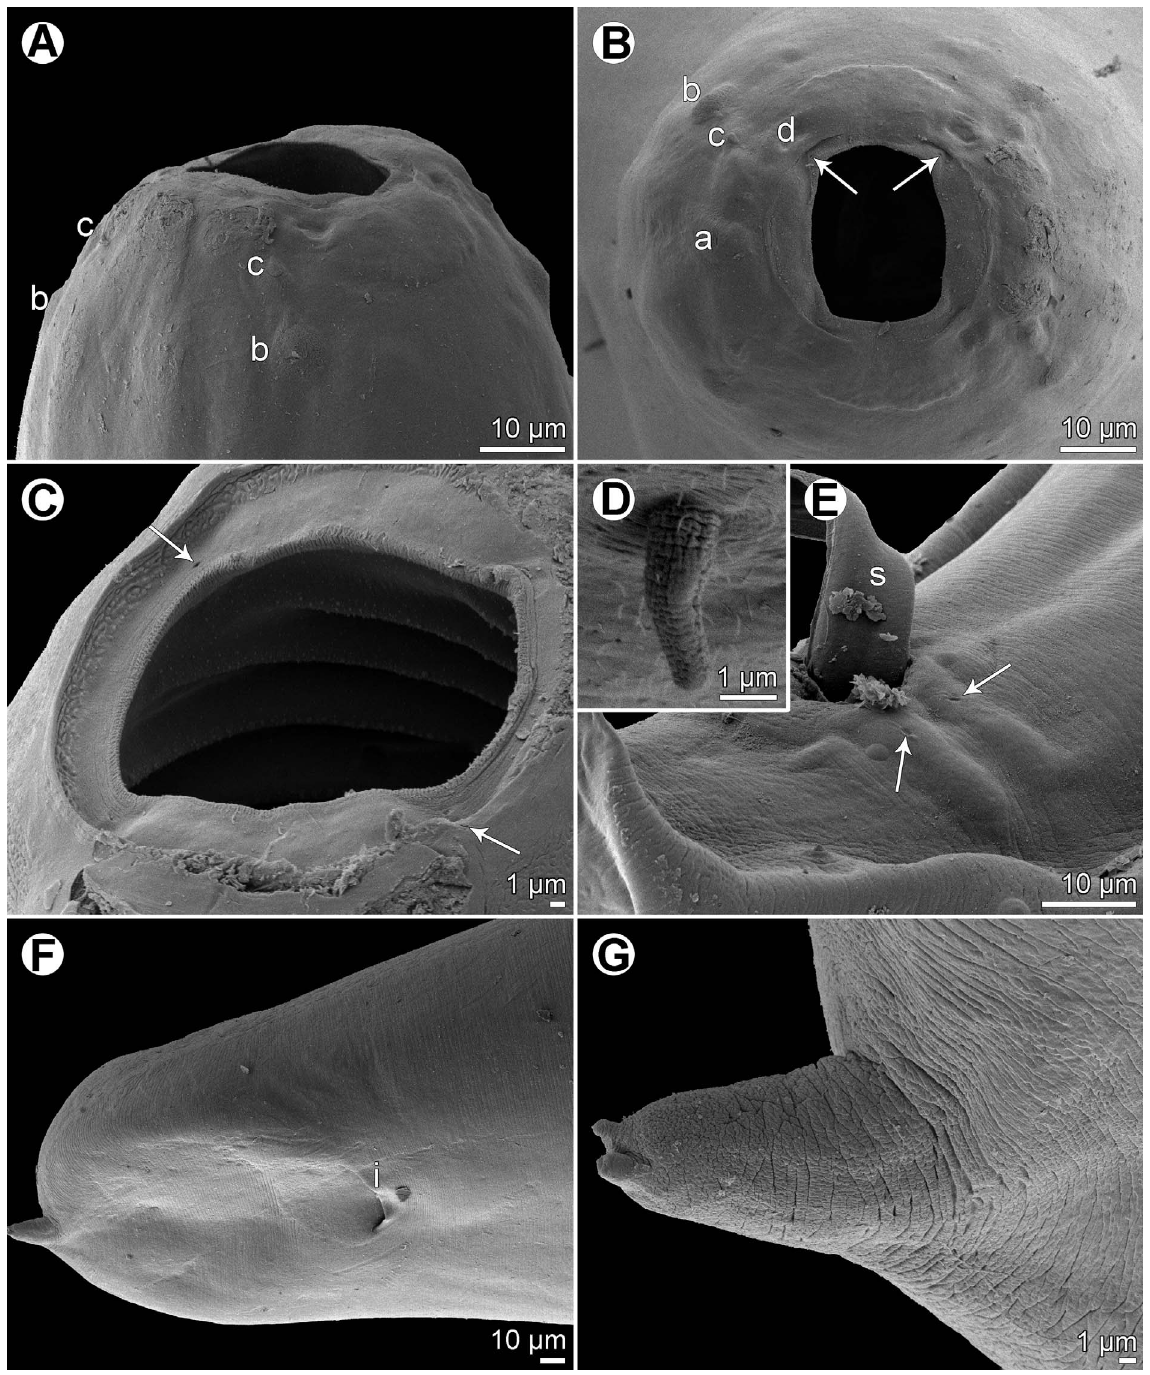
Figure 10. Procamallanus ( Spirocamallanus ) thalassomatis n. sp., scanning electron micrographs. (A, B) Cephalic end, sublateral and apical views, respectively (arrows indicate circumoral pores); (C) region of oral aperture, subapical view (arrows indicate circumoral pores); (D) deirid; (E) region of cloaca, sublateral view (arrows indicate pores of fl at papillae around cloaca); (F) tail of gravid female, ventral view; (G) caudal projection of gravid female, sublateral view. (a) amphid; (b) cephalic papilla of external circle; (c) cephalic papilla of middle circle; (d) cephalic papilla of internal circle; (i) anus; (s)